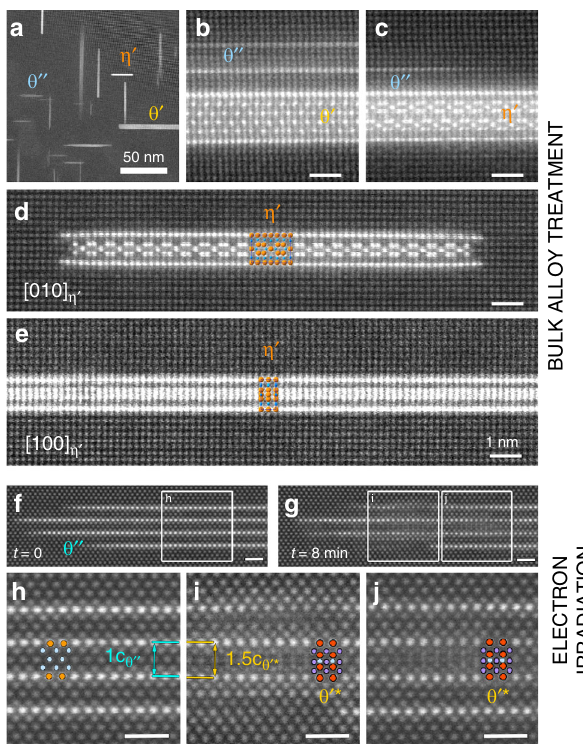
Fig. 5 TDN can be replicated in a bulk alloy and in samples subjected to a high-energy electron beam. TDN is observed in a bulk sample subjected to a bulk heat treatment designed to release extra vacancies ( a – e ), and in a thin specimen irradiated by 300 keV electrons ( f – j ). a Shows a typical view of the microstructure along <100> α following ageing at 160 °C, a small deformation and further ageing at 160 °C. Many θ ″ precipitates have transformed into the θ ′ and η ′ phases. b , c Present evidence that θ ′ and η ′ nucleated inside a θ ″ template precipitate. d , e Show well developed η ′ precipitates along their [010] and [100] directions, respectively, with the crystal structure overlapped. f Shows a pristine θ ″ precipitate viewed along <110>. g Shows the same θ ″ precipitate after being subjected to the electron beam in scanning mode for 8 min. h – j are enlargements of the boxed regions highlighted in ( f , g ). Additional atom columns are clearly visible in ( i , j ) that are consistent with the crystal structure of θ ′ viewed along <110>, as illustrated by the overlapped crystal structures of θ ′ (red = Cu, purple = Al) and the matrix (light blue). However, the nuclei are in fact a disordered analogue of θ ′ , θ ′ * (see Supplementary Fig. 11). Unlabelled scale bars correspond to 1